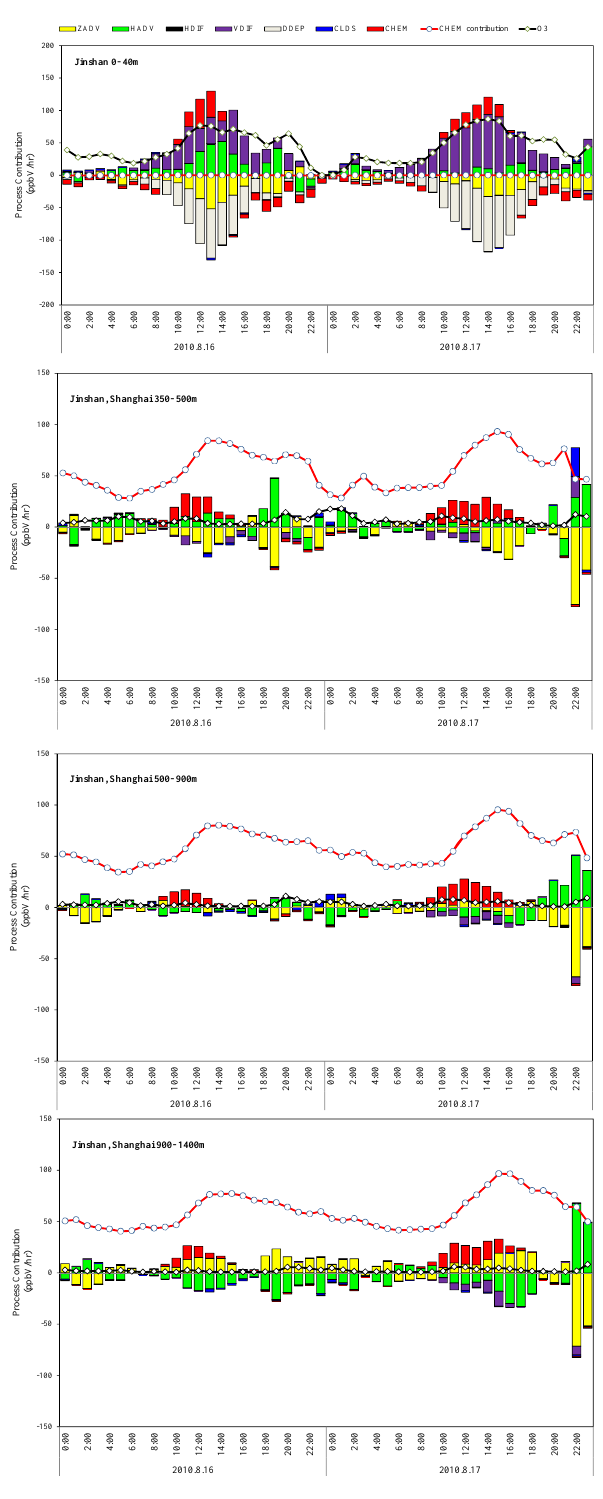
Fig.10. Atmospheric processes contribution to net O 3 density at Jinshan site during August 16--17, Fig. 10. Atmospheric processes contribution to net O 3 density at 2010. Jinshan site during 16–17 August Compared with the urban Shanghai area, the VOC emissions at the Jinshan site are more significant than the NO emissions, showing that the gas-phase chemistry in this region mainly plays a positive effect on O 3 production, while the NO titration to O 3 is weaker.